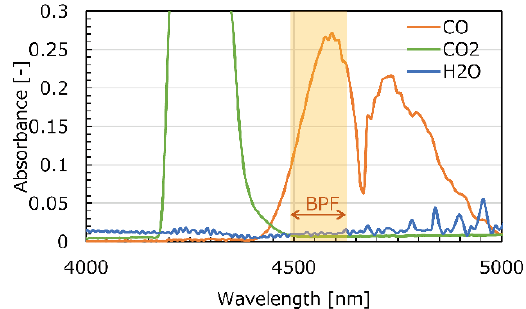
Figure 3. Schematics of the imaging method.